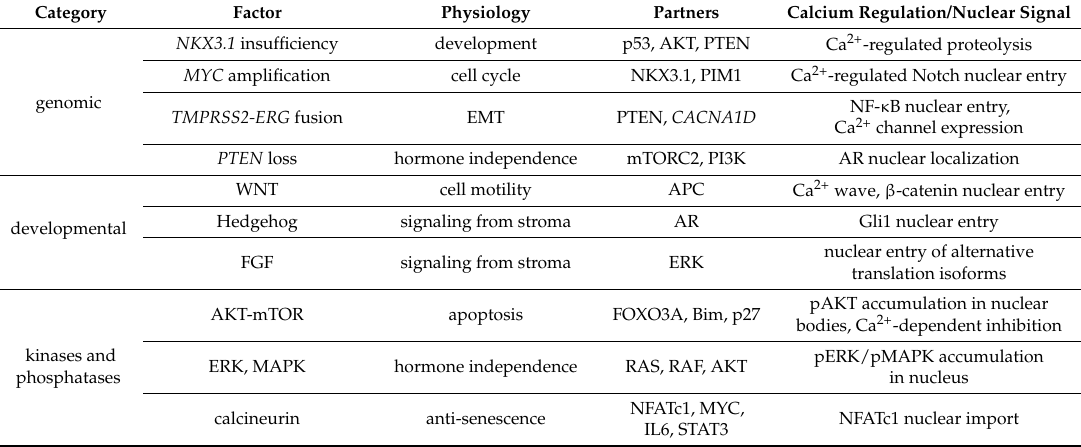
Table 1. General regulatory factors involved in the calcium and nuclear signaling in prostate cancer. The molecular factors and their cell-physiological effects are categorized, and the corresponding calcium and nuclear events sketched out in the approximate order of their treatment in the